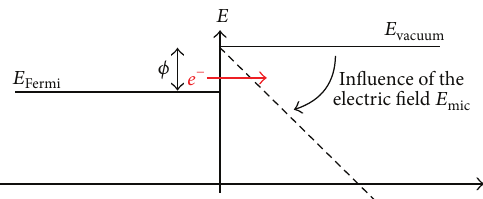
Figure1:Influenceofanenhancedelectricfield 𝐸 barrier and the tunneling of electrons.